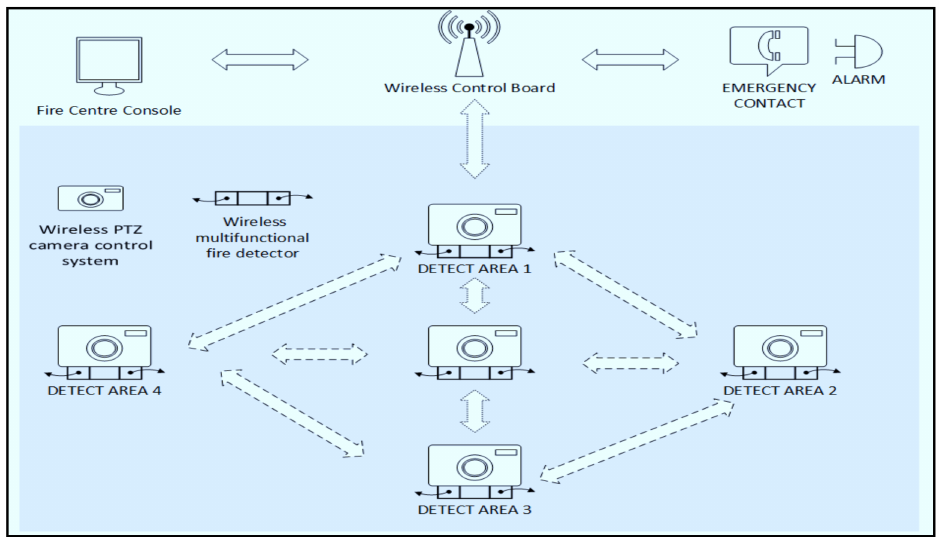
Figure 3. Framework outline of a new wireless fire detection and alarm system